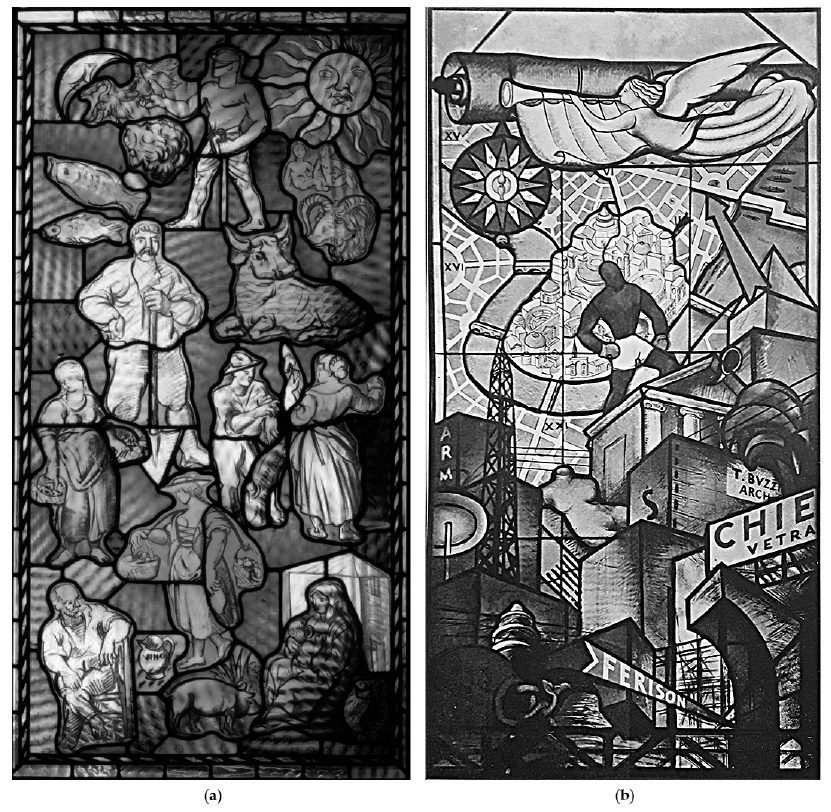
Figure 3. ( a ) Pietro Chiesa (excution), composition by Achille Funi, Strapaese , 1928, in «Domus», n. 5, May, 1928, pag. 17. ( b ) Pietro Chiesa (execution), composition by T. Buzzi, Stracittà , 1928, in «Domus», n. 6, June, 1928, pag.